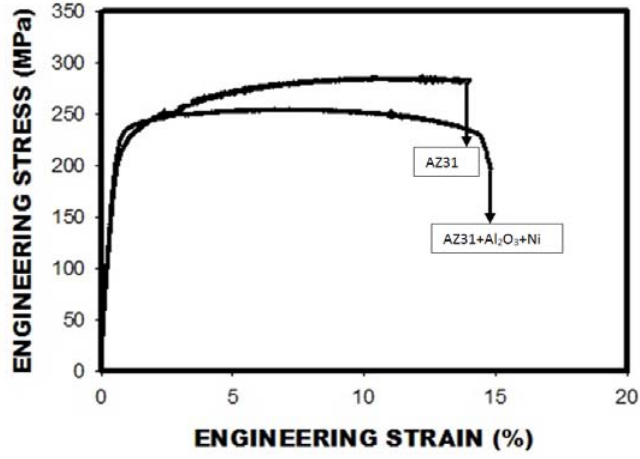
Figure 2. A comparison of the engineering stress versus engineering strain curves of the unreinforced alloy (AZ31) with the dual particle reinforced magnesium alloy O + (AZ31 + Al 2 3